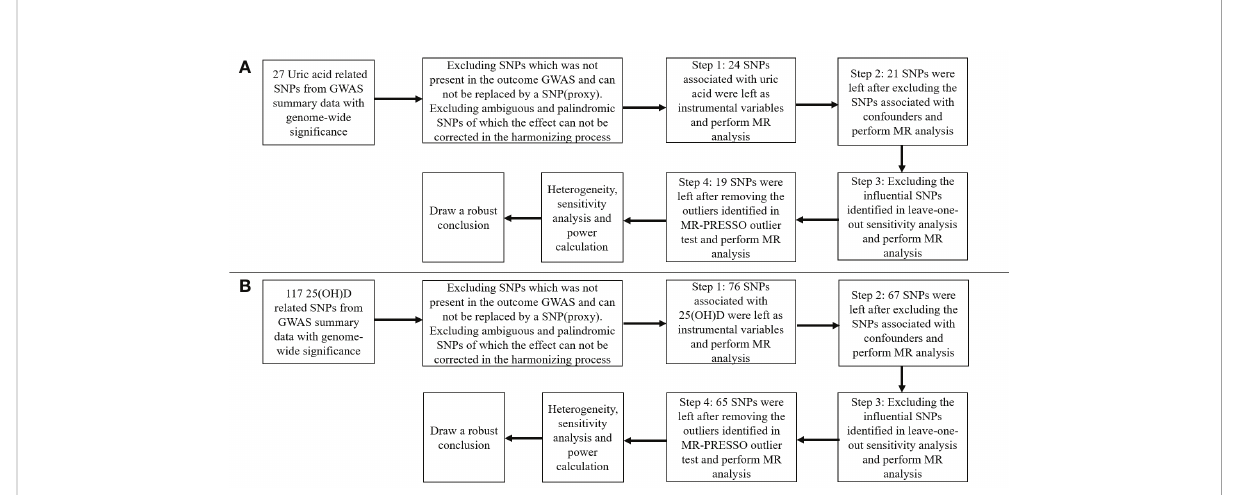
FIGURE 2 Flow chart about the analytical methods and how the MR analysis was performed step-by-step. (A) serum uric acid on 25-hydroxyvitamin D; (B) 25-hydroxyvitamin D on serum uric